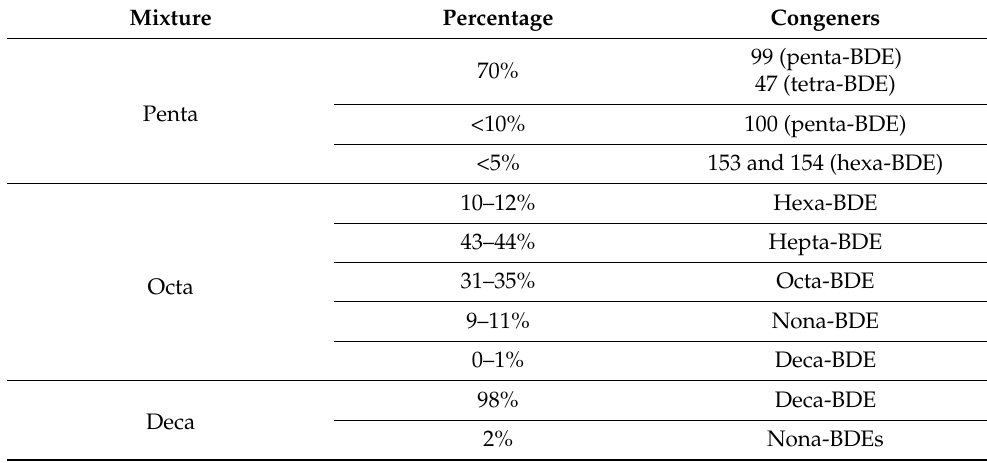
Table 2. PBDEs (polybrominated diphenyl ethers) commercial mixtures